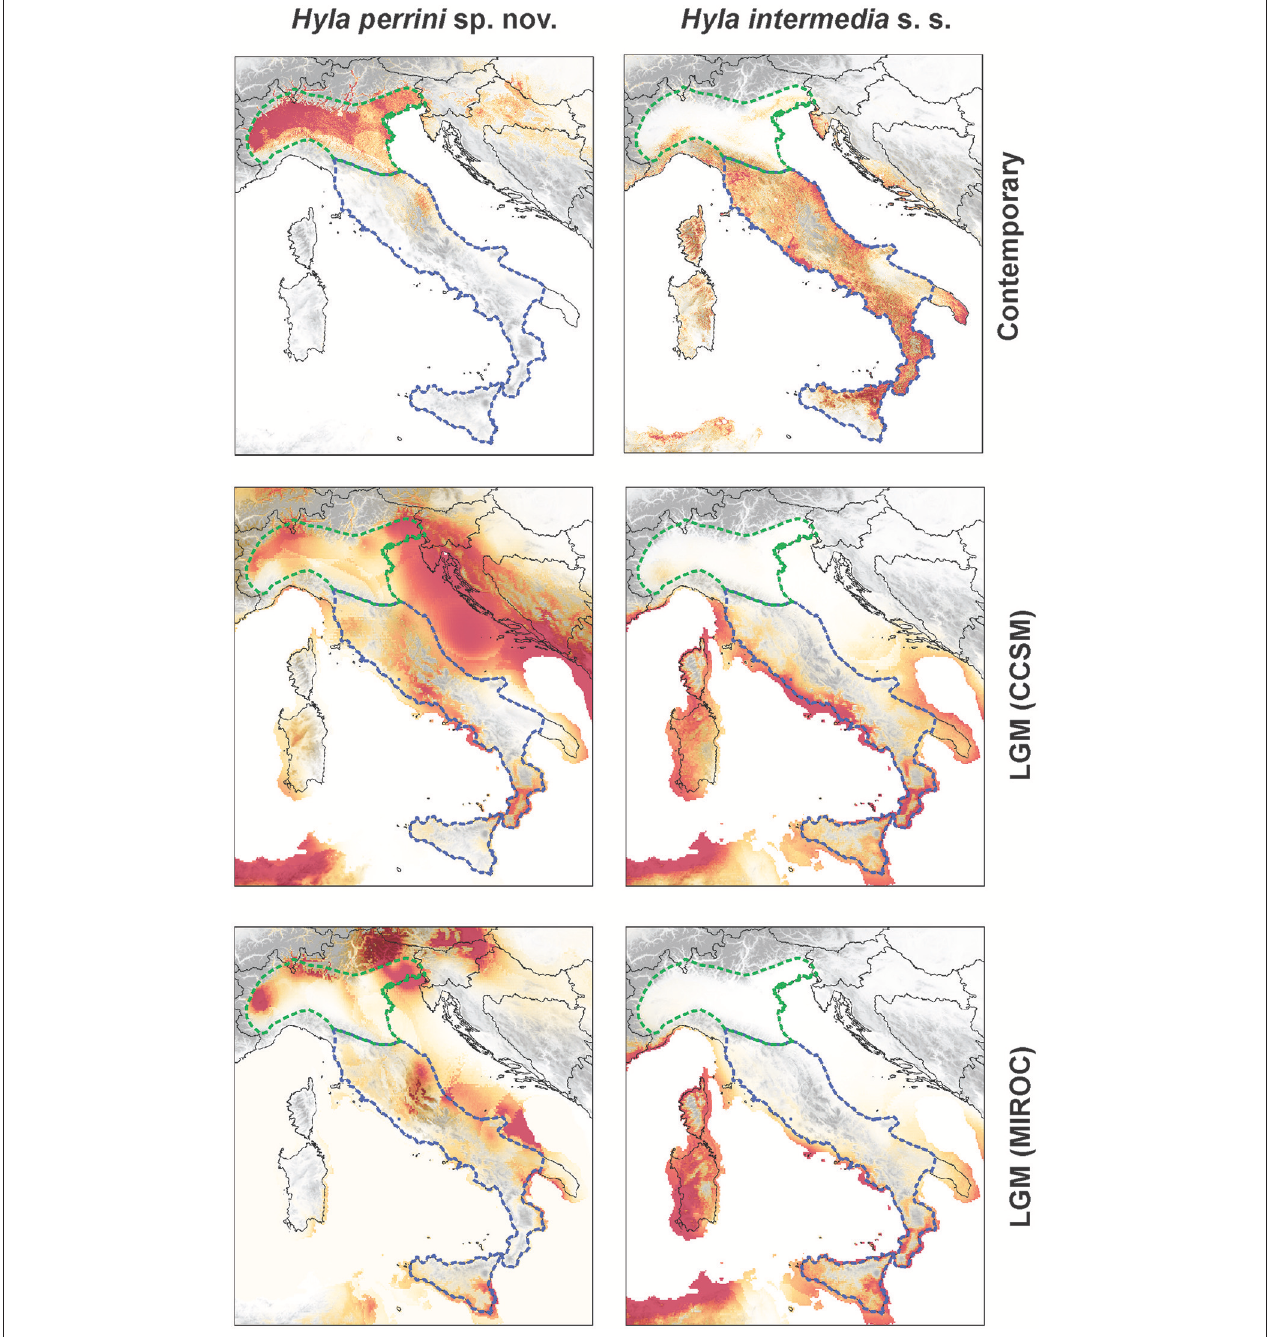
FIGURE 6 | Projection of the ecological niches for H. perrini sp. nov. (Left) and H. intermedia s. s. (Right) under current (top) and Last Glacial Maximum (LGM; 21’000 years ago) environmental conditions from the Community Climate System Model (CCSM, middle ) and the Model for Interdisciplinary Research on Climate (MIROC, bottom ). Parameter contributions are available in Table S2 . The maps were built in QGIS 2.18 using map layers from ESRI. Our complementary genetic approaches suggest that these two taxa are worthy of a specific status, in light of the current taxonomic divisions of other European amphibians. First, their deep, congruent mtDNA and nuclear divergence (averages: